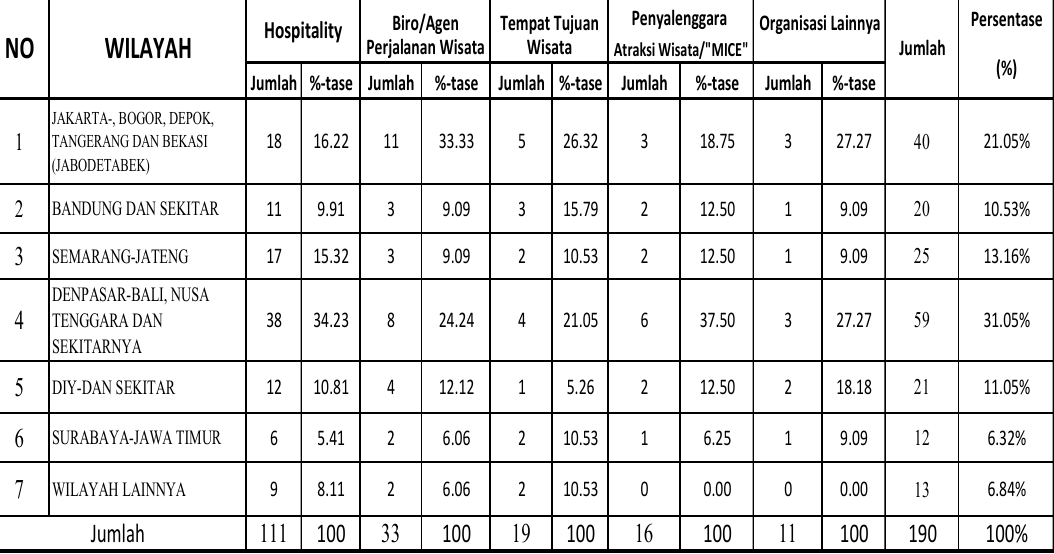
TABEL 2. DISTRIBUSI LOKASI